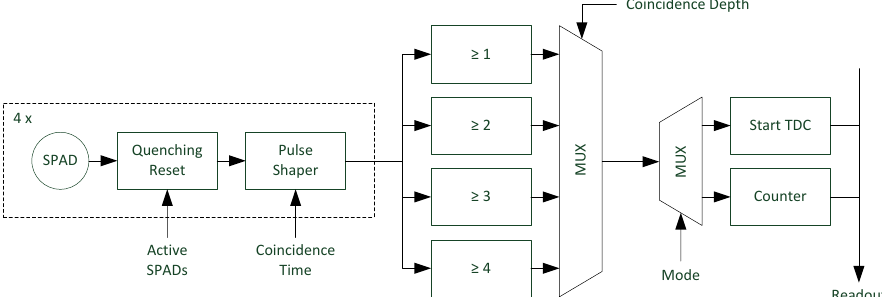
Figure 6. Block diagram of the sensor pixel. Each pixel uses four SPADs for the detection of photon coincidences. The coincidence time is adjusted by a variable pulse shaper and the coincidence depth by choosing one of the four different logical circuits processing the four SPAD outputs.